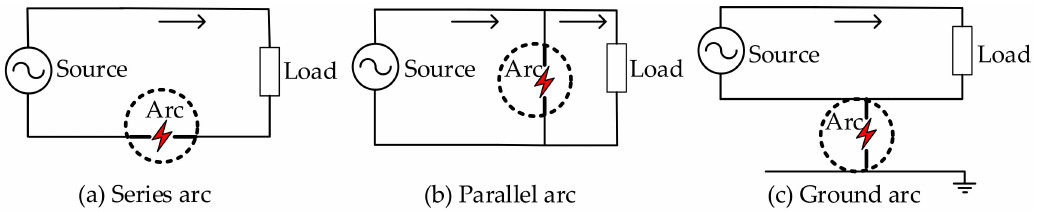
Figure 1. Types of arc